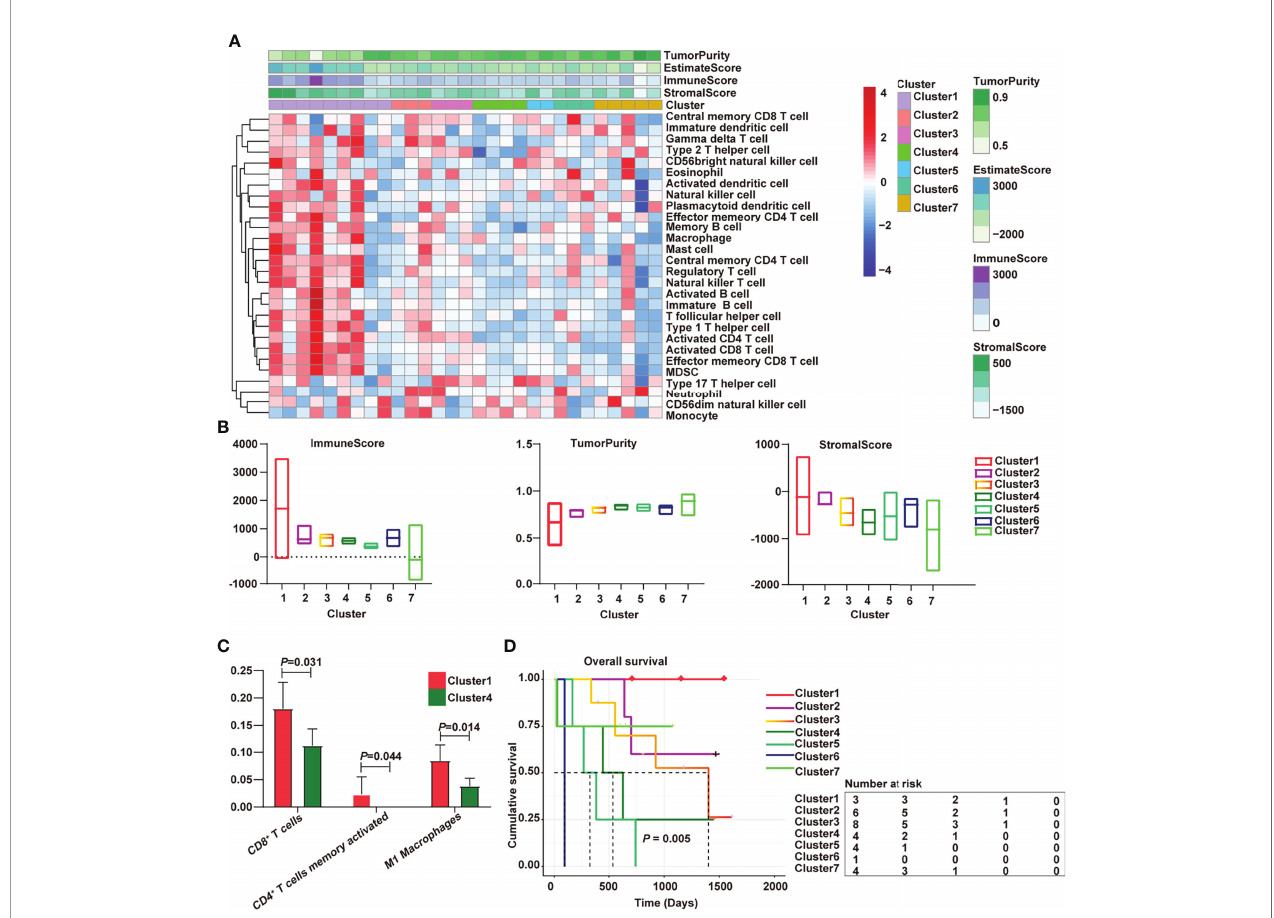
FIGURE 1 | Immunological characterization of cholangiocarcinoma has been implicated in overall survival. (A) Heatmap of the immune clusters of cholangiocarcinoma; (B) Immune score, stromal score, and tumor purity in the seven clusters; (C) Differential immune cells between cold and hot tumors; (D) Kaplan – Meier curves of the association of the seven subtypes with overall